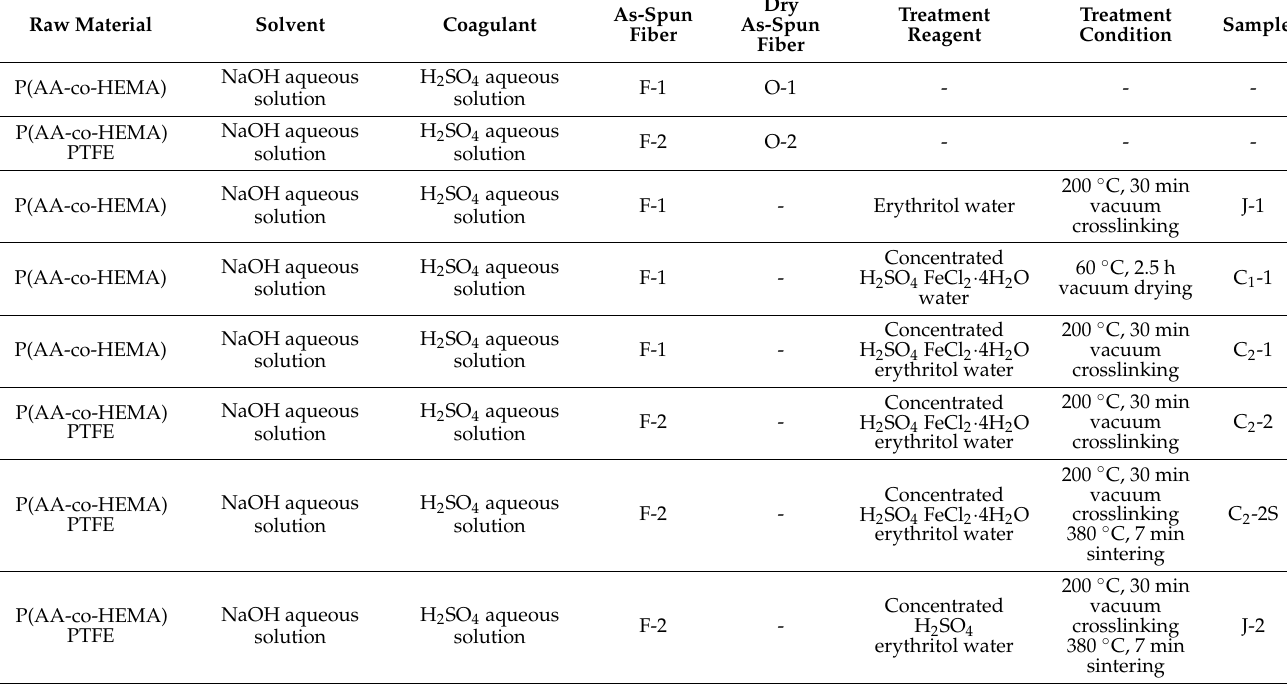
Table 1. The definition of fiber samples prepared as described in Sections 2.3 and